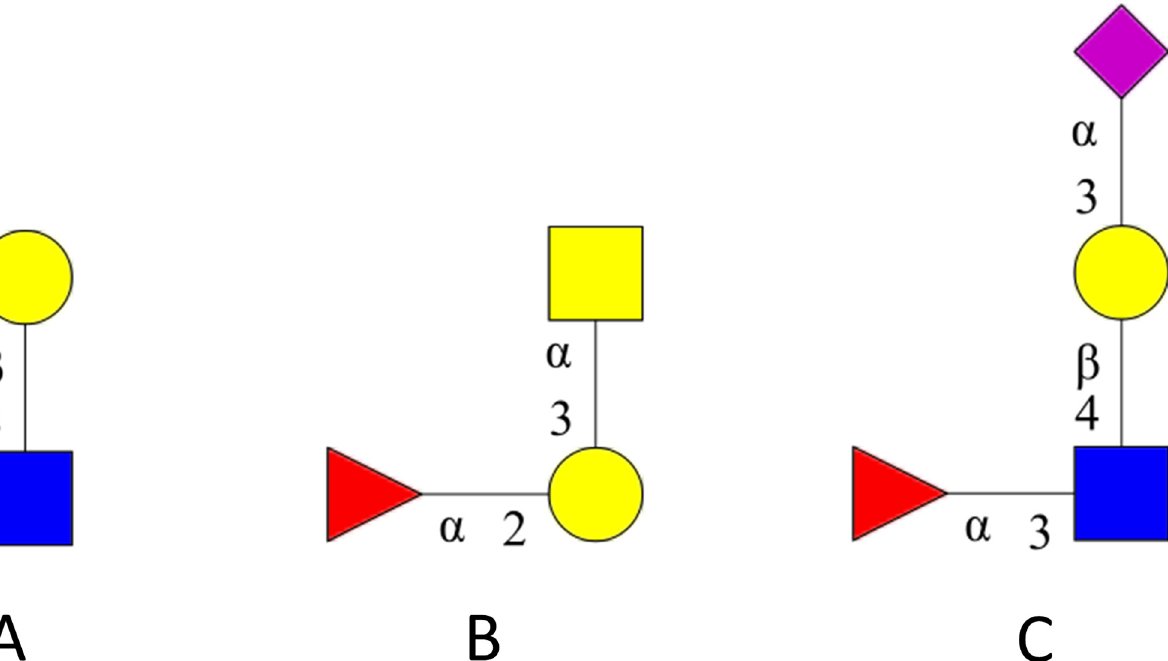
Fig 5. 2D structure of query glycoepitopes. The 2-dimensional structure of three well-known glycoepitopes listed in Table 1, namely (A) Lactosamine Type One. (B) Blood Group A. (C) Sialyl Lewis X is shown. Response time for each is shown in Table 1.